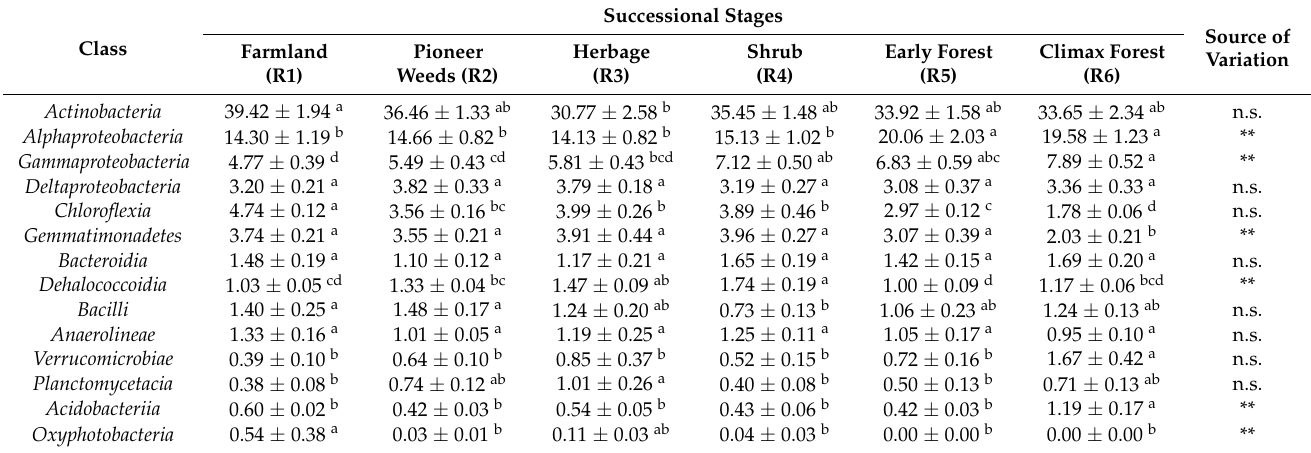
Table 2. Relative abundance (% of individual taxonomic groups) of the dominant bacterial classes (mean ± SE, n = 4) present in the soil (0–20 cm depth) microbial communities of different successional stages on the Loess Plateau of